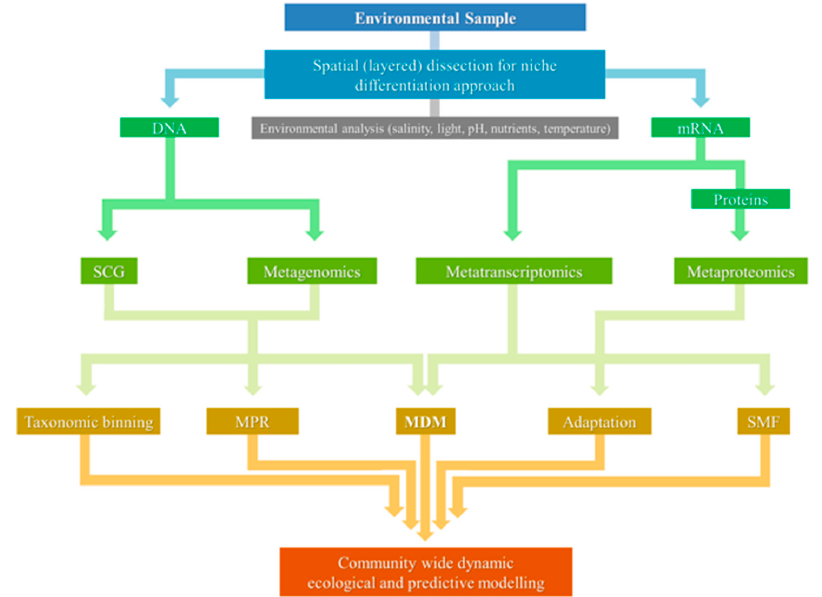
Figure 2. Schematic illustrating the evolving approaches and complementary pipelines in the study of hypersaline microbial mats and other “extreme” environments. MDM—Microbial dark matter; MPR—Metabolic pathway reconstruction; SCG—Single cell genomics; SMF—Specific metabolic function.